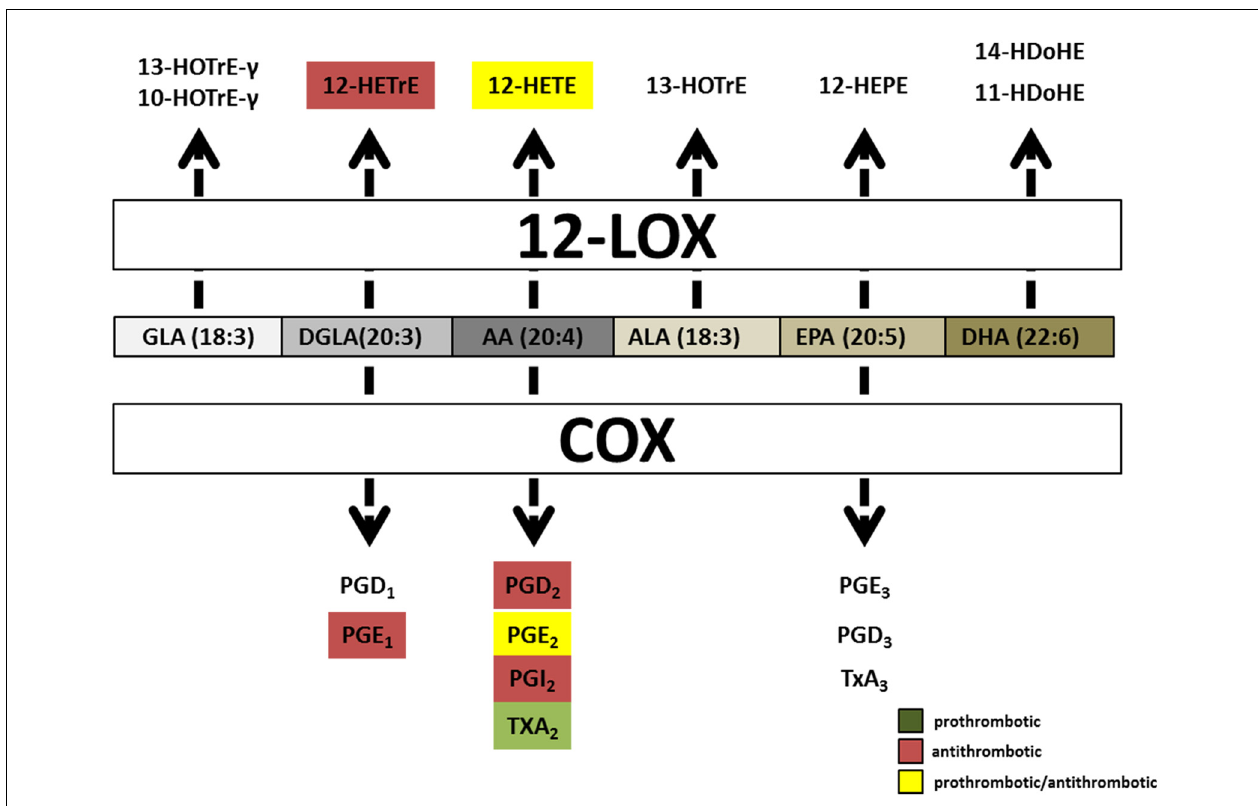
FIGURE 4 | Hemostatically active oxylipins derived from COX and platelet 12(S)-LOX. Common oxylipin precursors (GLA, DGLA, AA, ALA, EPA, and DHA) are all substrates for platelet 12(S)-LOX while COX produces oxylipins predominately from EPA, DGLA, and AA. Both COX